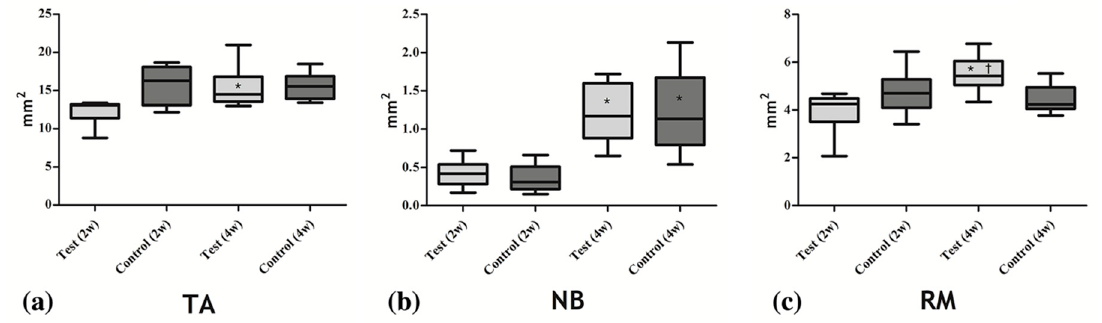
Figure 5. Box plots representing the histomorphometric analysis. ( a ) the area of total augmentation, ( b ) the area of newly formed bone, ( c ) the area of residual bone substitute material, TA: total augmented area, NB: newly formed bone, RM: residual bone substitute material. * Statistically significantly different from 2 weeks. † Statistically significantly different from the control group.